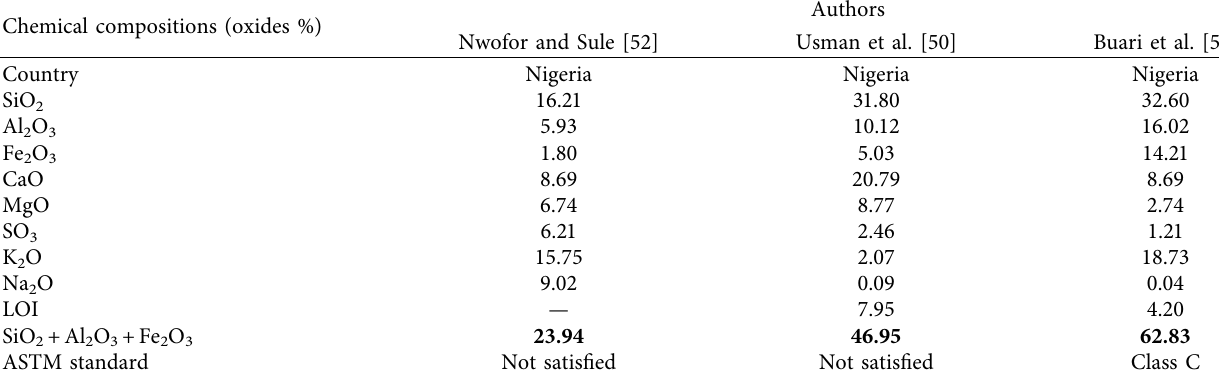
Table 4: Chemical composition of groundnut leaves’ ashes (GNA).